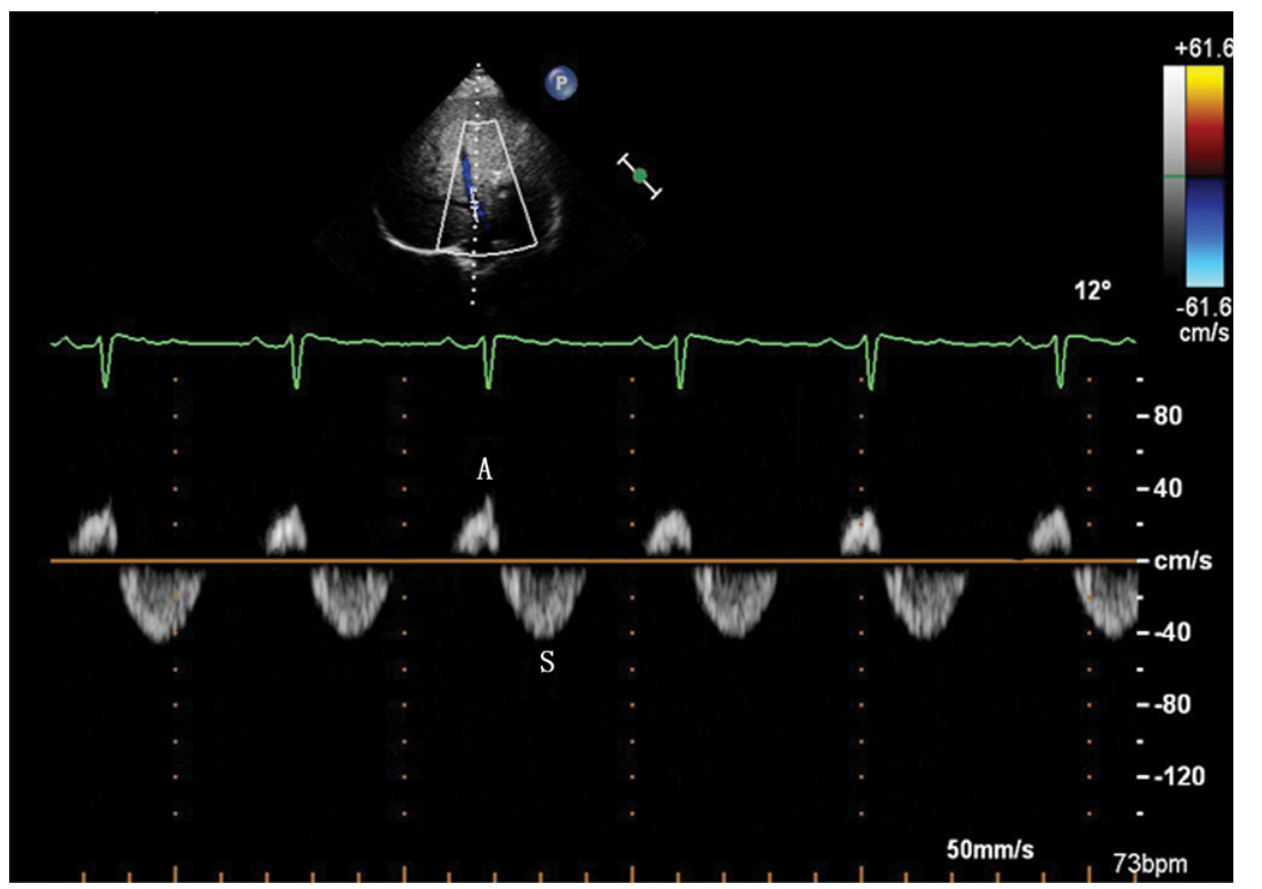
Fig 3. Bi-phasic Doppler flow spectra of the MHV in the PH group. Doppler spectra of MHV obtained from a patient with patent ductus arteriosus with the MPAP of 96 mmHg. The bi-phasic waveform of MHV includes S wave and A wave.